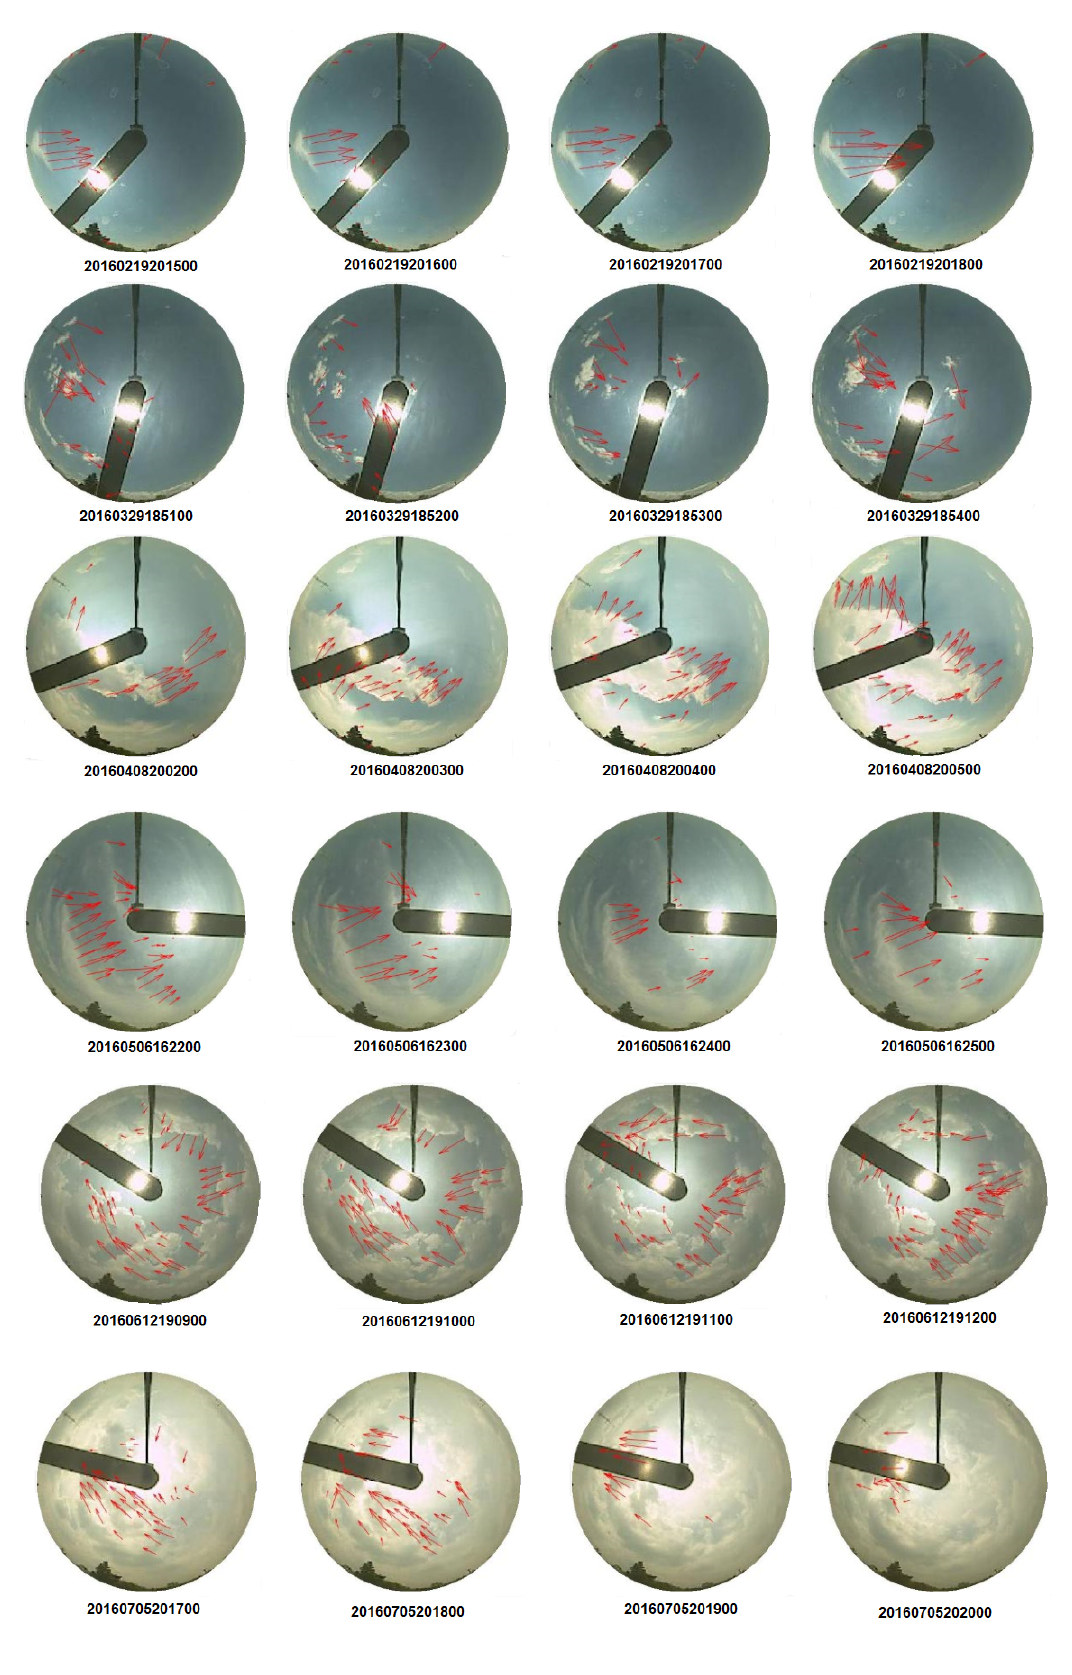
Figure 5. Examples of the Lucas-Kanade method applied in different